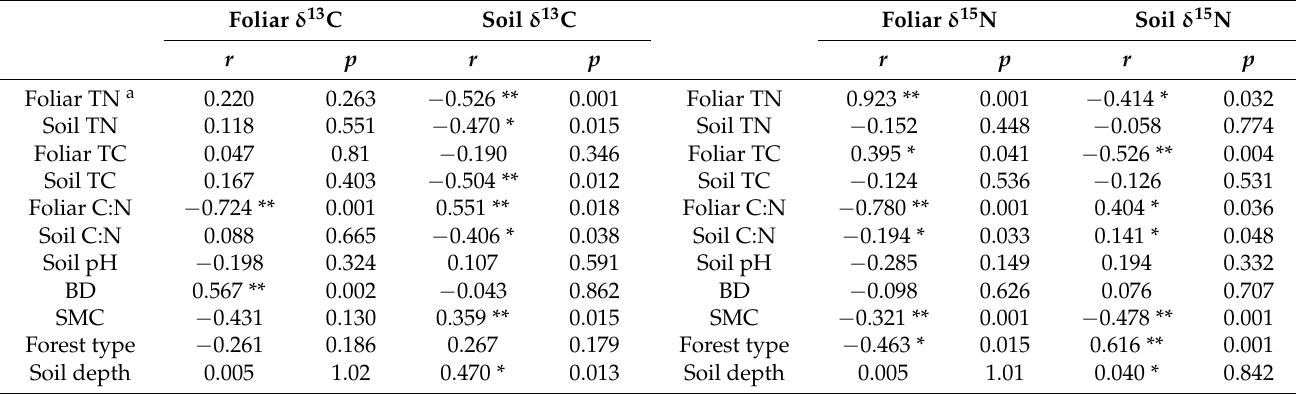
Table 3. Pearson correlation between soil and foliar δ 13 C and δ 15 N and potentially influential factors across forest types and soil depths. Foliar δ 13 C